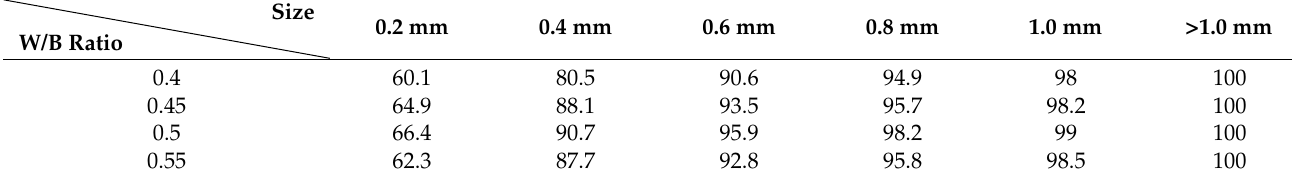
Table 5. Cumulative pore size distributions with different w/c